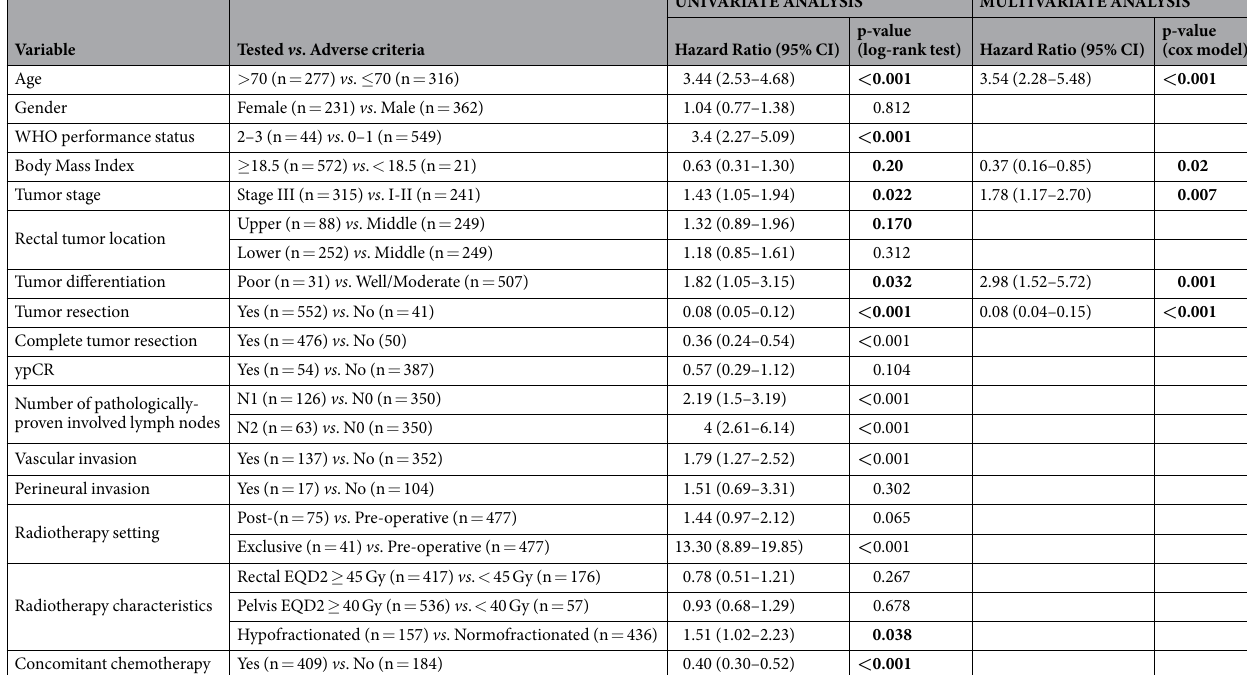
Table 4. Prognostic factors for overall survival in the whole set of patients (n = 593 patients). 95% CI: 95% confidence interval; ypCR: Pathological complete response. EQD2: 2GY-per-fraction equivalent dose. All p-values ≤ 0.2 in univariate analysis were tested in multivariate analysis, except variables related to surgery since they substantially limited the number of patients and except correlated variables (correlation with p < 0.001). Finally, only bold typed values were tested in multivariate analysis. The sum of sub-populations might be inferior to 593 in some cases because of missing